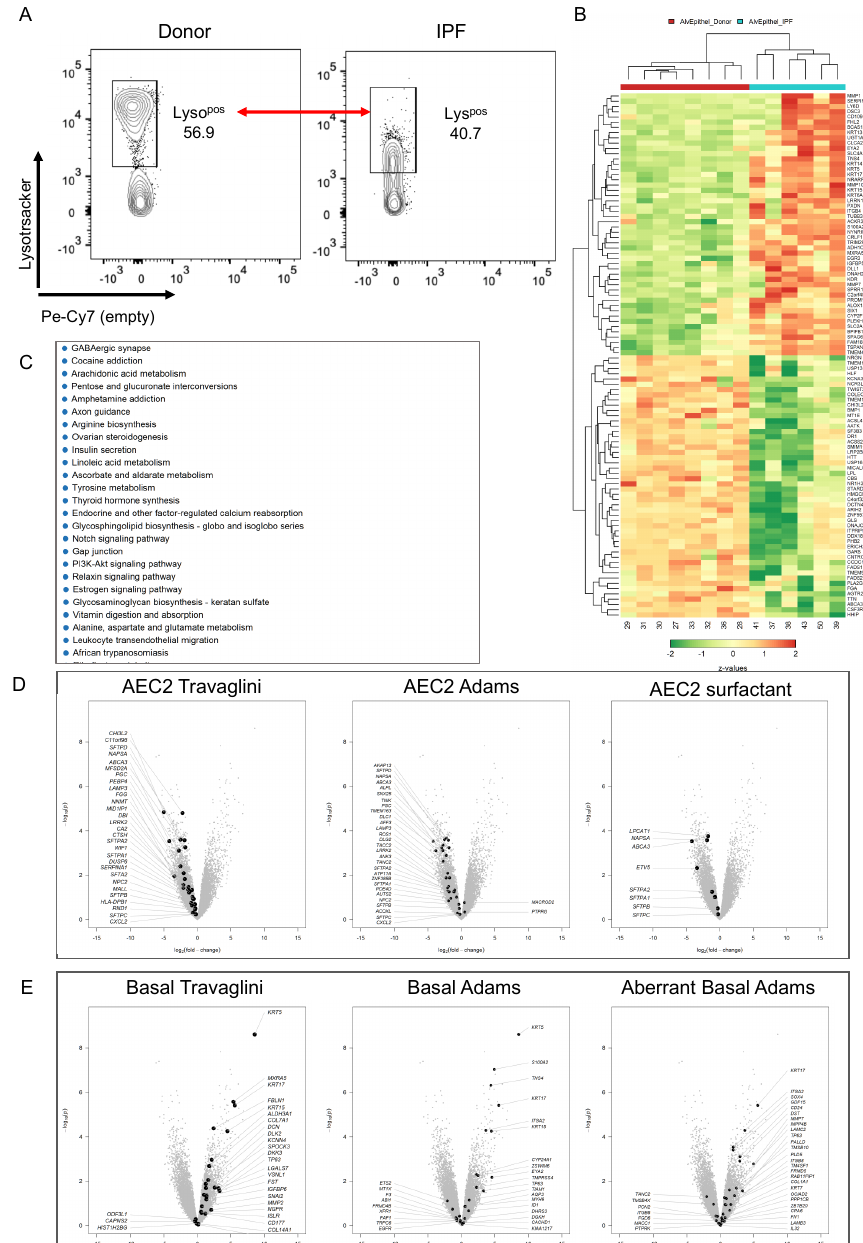
Figure 5. Transcriptomic profiling of the Lyso pos population in IPF. Donor Lyso pos ( n = 8) and IPF Lyso pos ( n = 6) epithelial cells were isolated by flow cytometry and their transcriptomic profiles were determined by microarray analysis. ( A ) Flow cytometry panels showing the sorting strategy for the two populations. ( B ) Heat map of the first upregulated and downregulated genes in IPF Lyso pos vs. donor Lyso pos . ( C ) KEGG pathway analysis showing the first 20 most differential regulated pathways. ( D ) The transcriptomic signatures of AEC2 that were identified by Travaglini et al. and Adams et al. were superimposed on the vulcano plots depicting the upregulated and downregulated genes in IPF Lyso pos compared to donor Lyso pos (left and middle plots). The right plot shows the distribution of surfactant production and processing genes. ( E ) The transcriptomic signatures of various populations of donor and IPF basal cells that were identified by Travaglini et al. and Adams et al. were superimposed on the vulcano plots depicting the upregulated and downregulated genes in IPF Lyso pos compared to donor Lyso pos